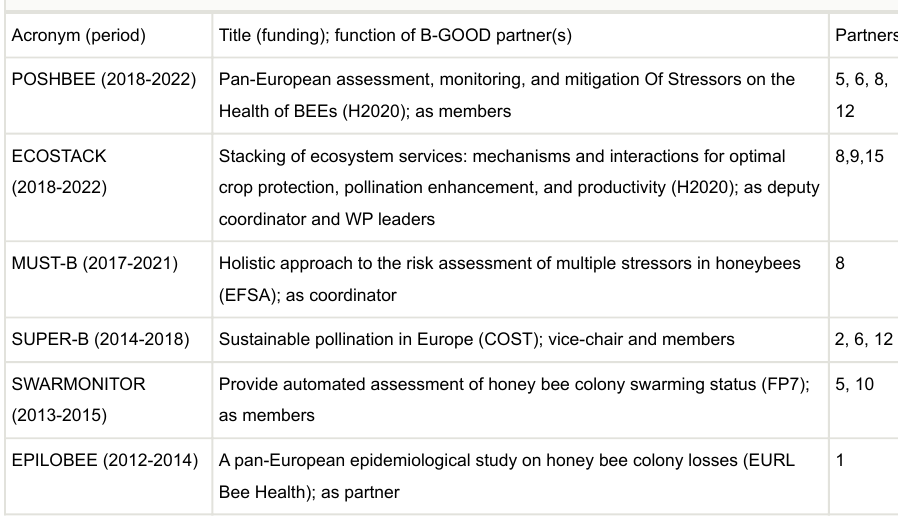
Former and ongoing EU projects with a link to